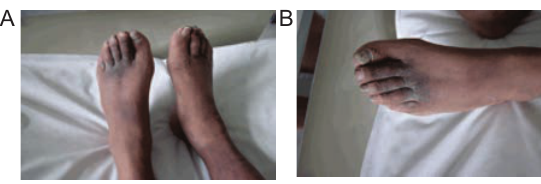
Figure 4. Extensive regression of Kaposi sarcoma after treatment (A and B), he only has hyperpigmented areas at knee levels, skin looks thin and delicate and easily bruised.